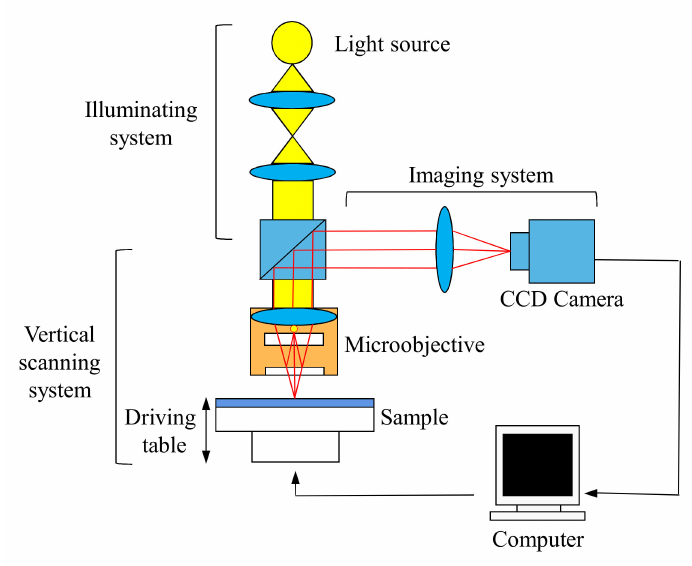
Figure 4. White light interferometry